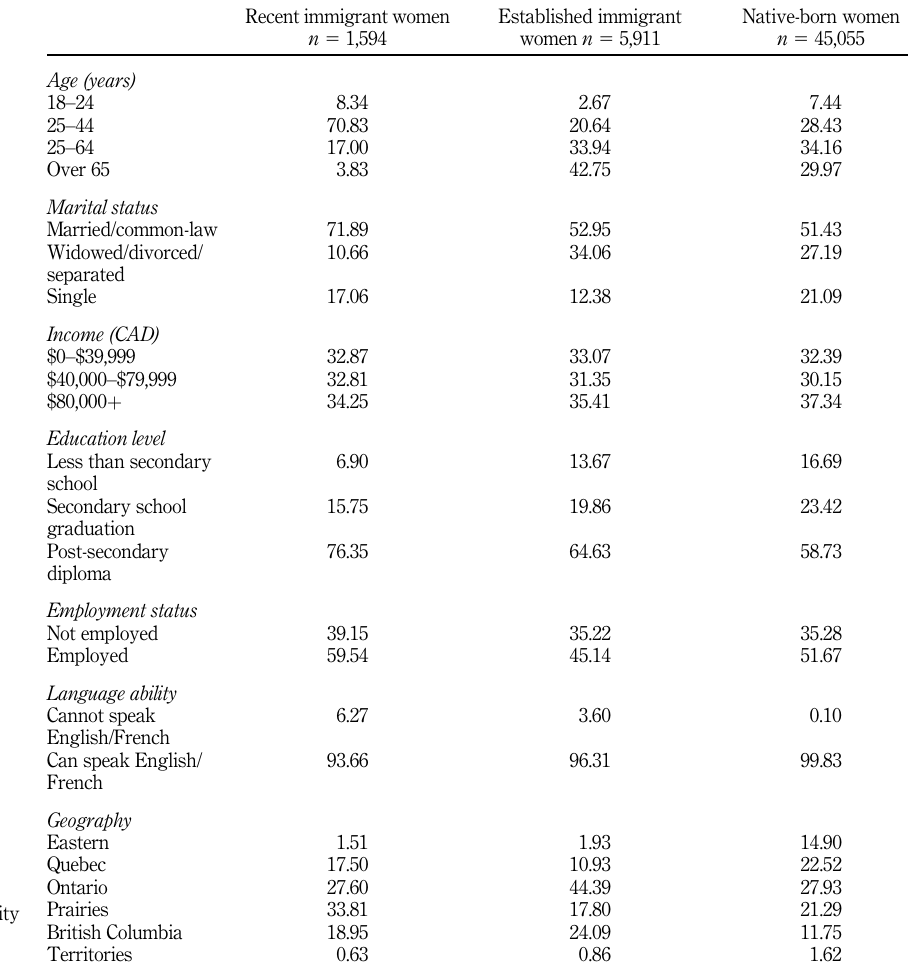
characteristics: Canadian community health survey (2015 –